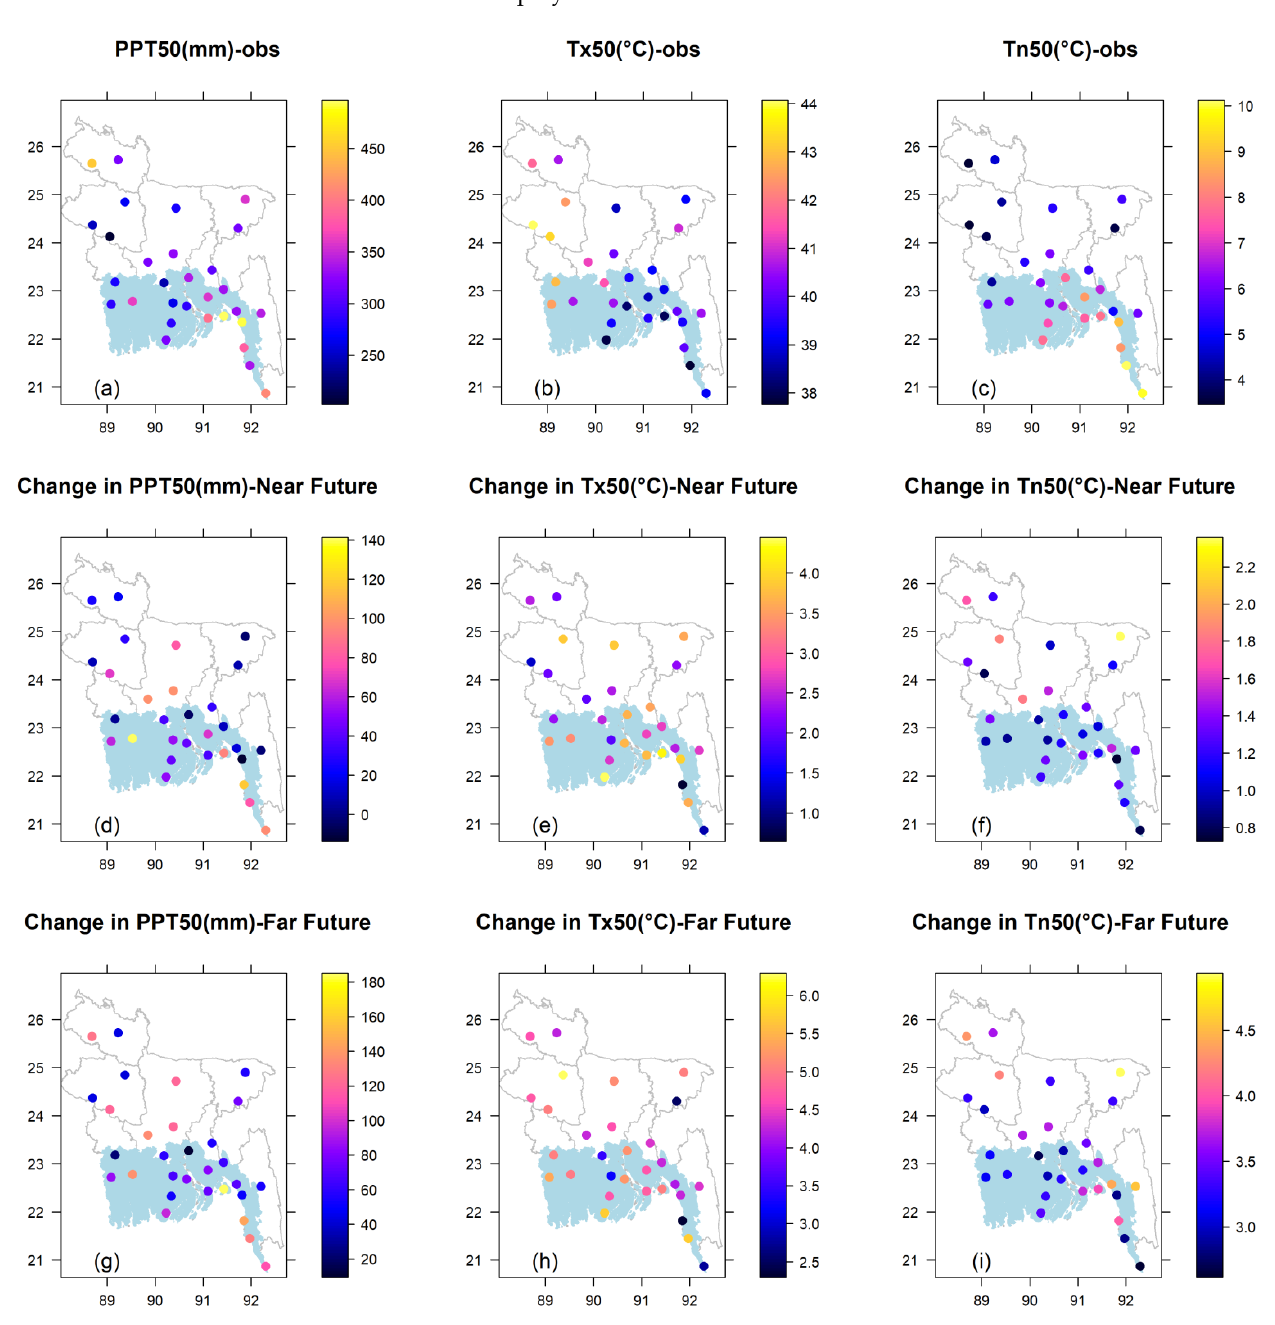
Figure 8. Spatial distribution of 50-year quantile based on observed data ( a ) PPT (mm); ( b ) Tx (°C) and ( c ) Tn (°C) and their changes under high emission scenario (SSP585) in the near future: ( d ) change in PPT (mm); ( e ) change in Tx (°C); and in the far future: ( f ) change in Tn (°C) and in the far future; ( g ) change in PPT (mm) ; ( h ) change in Tx (°C); ( i ) change in Tn (°C). In case of temperature extremes, contrasting behavior is noted for Tx50 and Tn50.